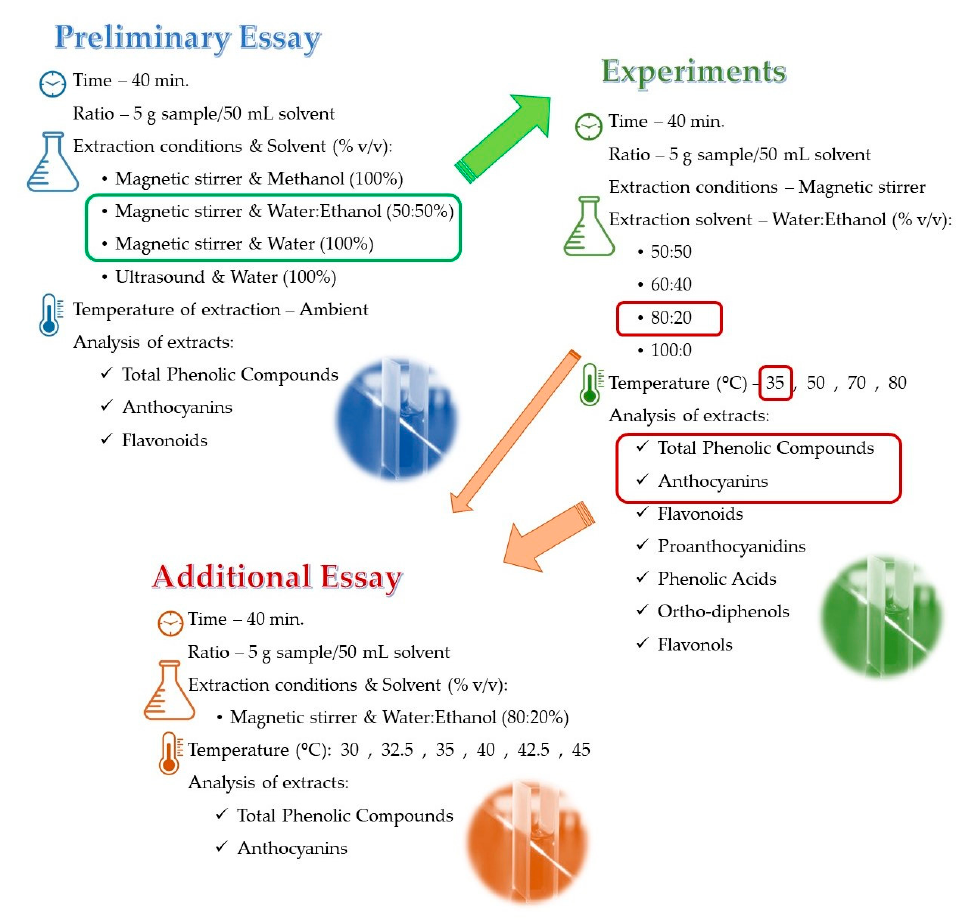
Figure 1. Schematic representation of the experimental conditions